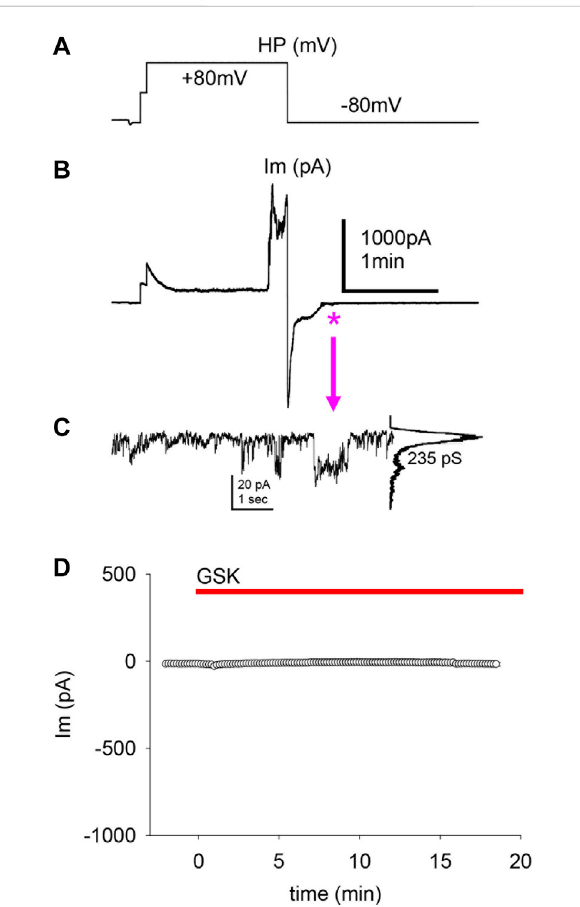
The transient peak Im was predictive of a cell ’ s response to depolarization and GSK1016790A treatment. (A – B) Applied voltages (A) and resultant WC Im (B) from single LEC with a large I peak in control conditions (no GSK present). A large, spontaneous increase of WC Im developed after ~1 min of sustained +80 mV pulse, and a fast return to initial Im levels ensued at a subsequent − 80 mV pulse. The swiftness of the WC Im increase impairs the assessment of HCh-like step-wise transitions. (C) Transitions of conductance consistent with Cx43 HCh (235 pS) were seen on an enlargment of the Im recovery end (asterisk and arrow). This value is the channel conductance ( γ ) of the larger transitions: current amplitude difference between the baseline (large peak) and the maximal opening (small peak), shown in the all-points histogram (right of the trace) of the illustrated events, divided by the voltage gradient ( γ = Δ Im/Vm). (D) Cells with a proportionally small I peak or proportionally larger I ss showed little or no response to GSK (average of n =